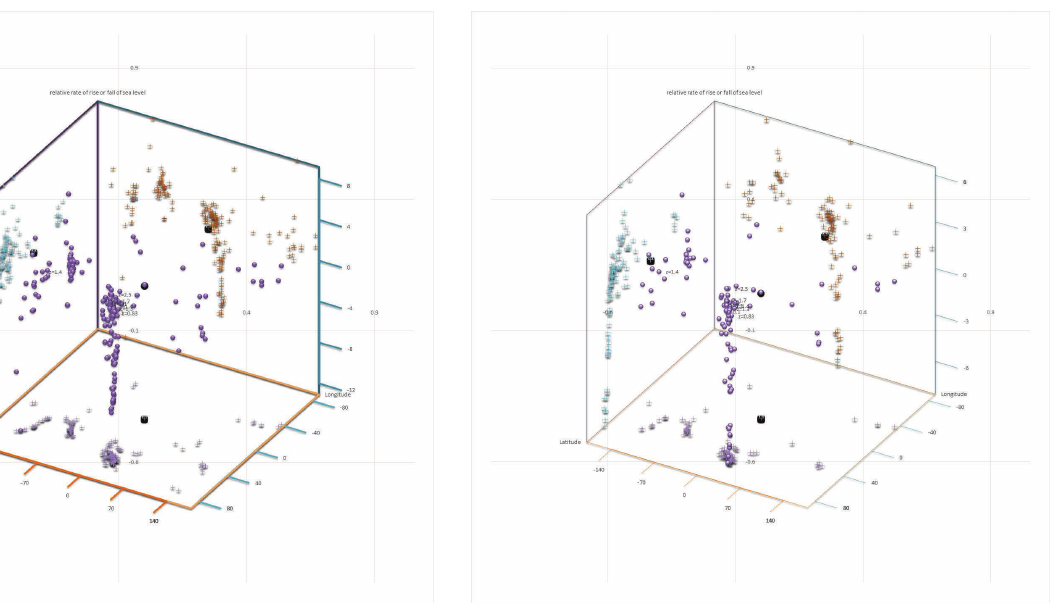
Fig. 4: Relative sea level velocity in the 100 tide gauges of the latest PSMSL survey with more than 80 years of recording in mm/year vs. latitude and longitude in degrees. These tide gauges have relative rates of rise ranging from + 6.56 to − 8.1 mm/year with an average of + 0.24 mm/year, with these values practically unchanged over the last two decades indicating the lack of any acceleration. These tide